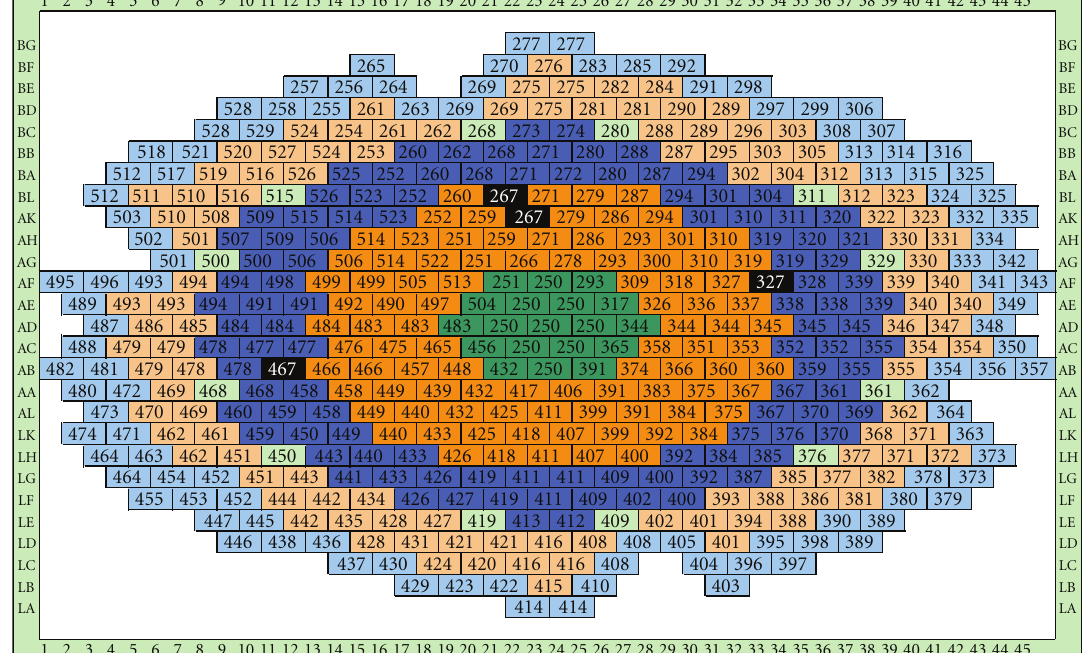
Figure 9: Failure predicted by TRANSURANUS code, case equilibrium burnup of the reference core accounting for shu ffl ing.